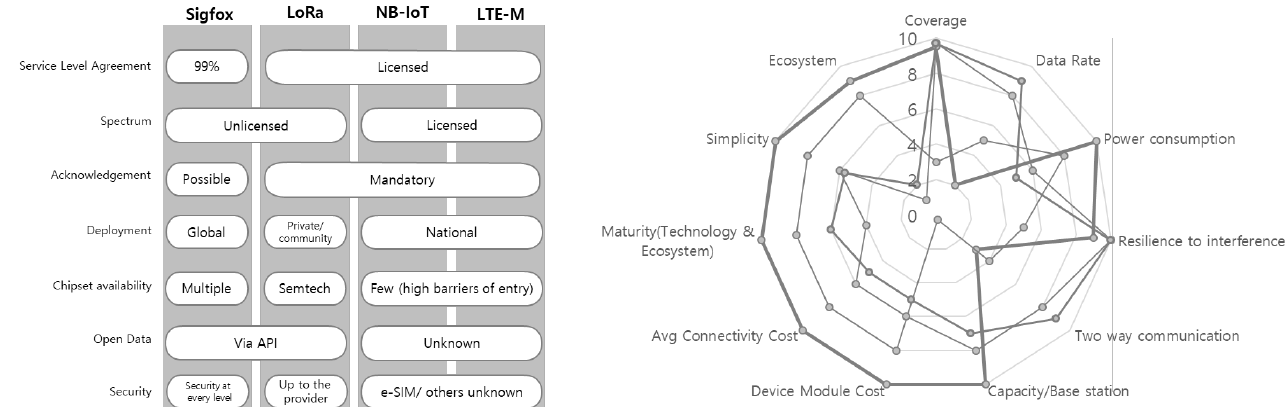
Figure 2. Features of Current Communication Technologies [3]. Table 1. Advantages and Disadvantages of Communication Methods [4 – 7].